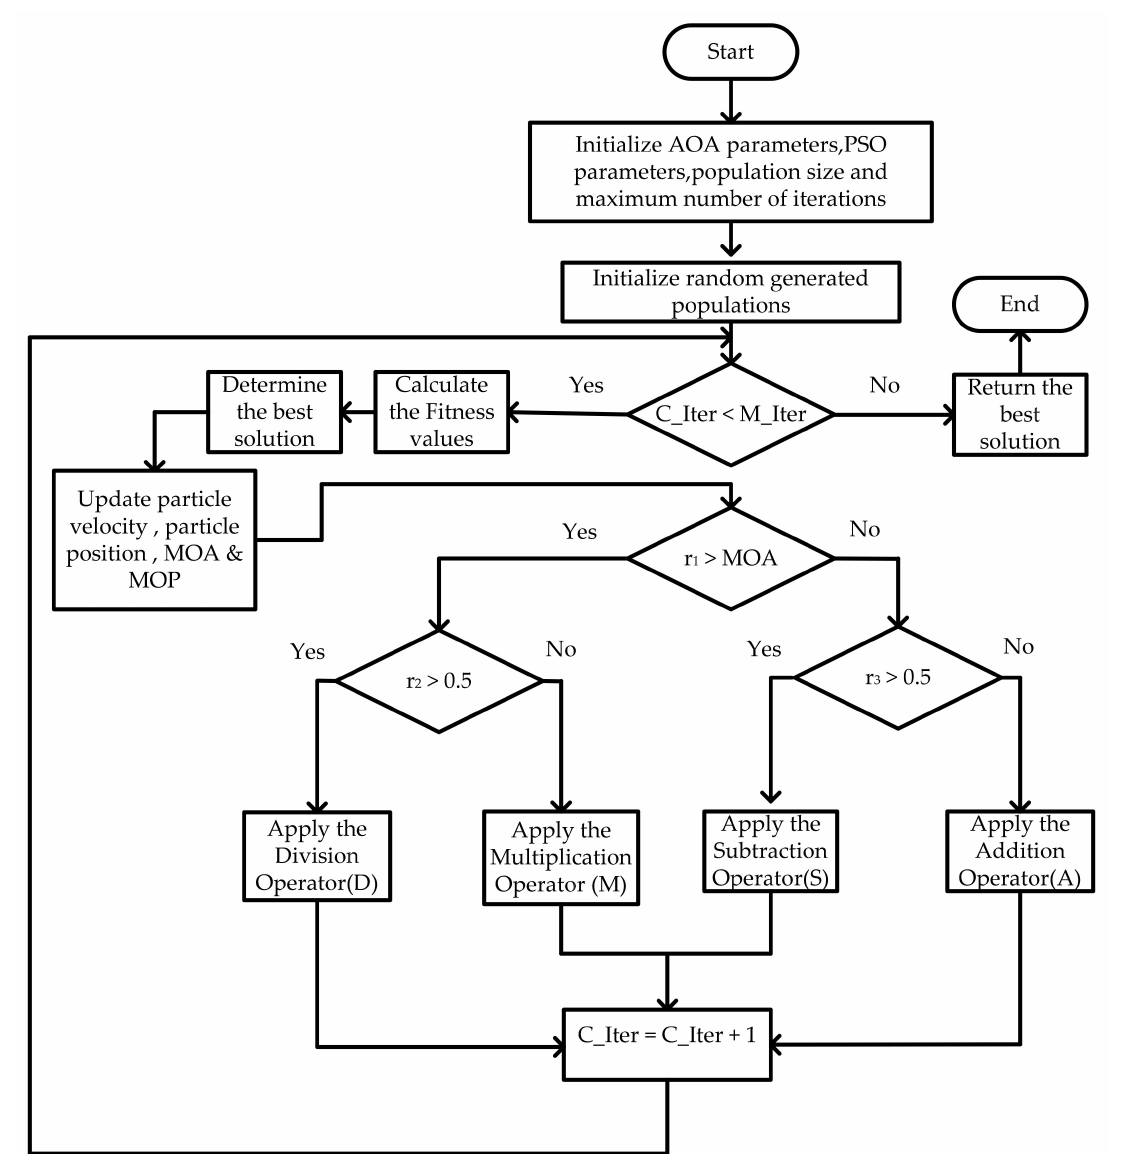
Figure 10. Flowchart of